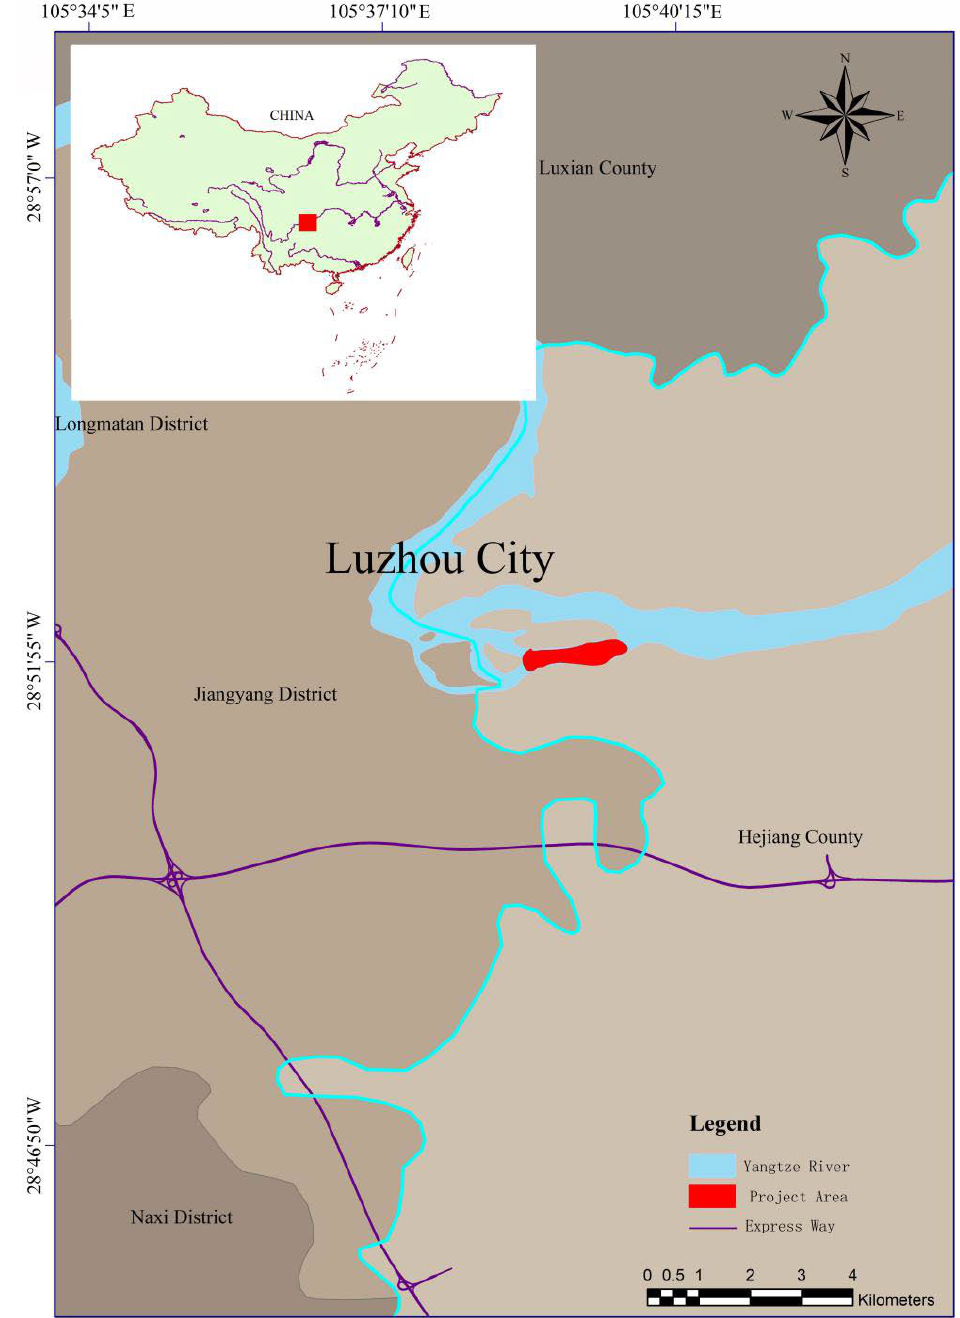
Figure 1. Location of the restoration project. The construction area selected for restoration is on the south bank of the Yangtze River. The existence of an island resulted in the formation of a side channel in this area. At high water levels, water enters the side channel from the west and discharges into the main channel from another side. The water depth within the reach is variable, ranging from 1.0 m to 7.0 m. The average length of the side channel is 3.0 km, and the average width is 0.3 km, the draw-down area of which is covered with gravel. The main goal of the fish habitat restoration project was to recover geomorphic heterogeneity and was implemented in